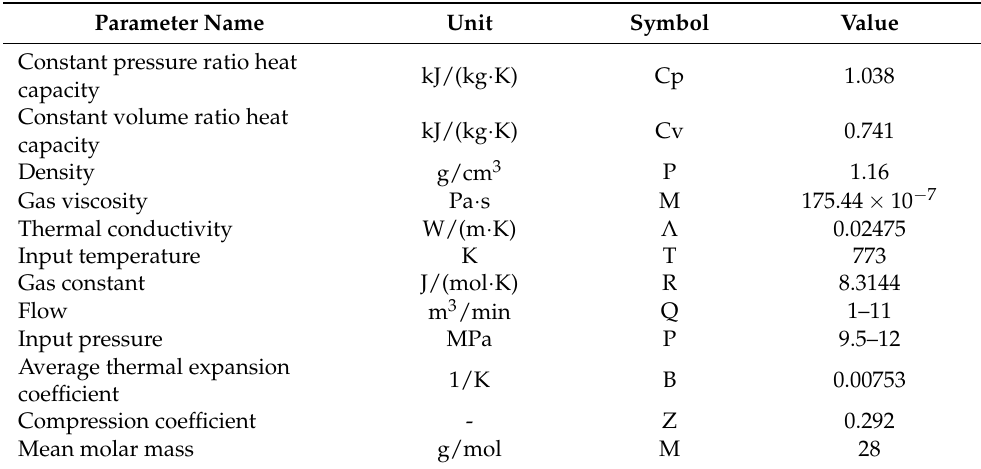
Table 5. Calculation parameters of